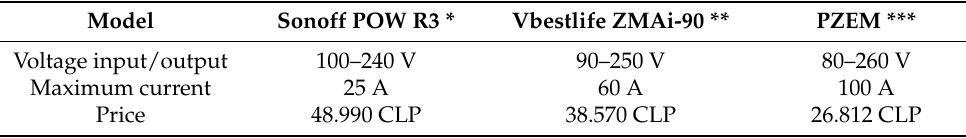
Table A2. Characteristics of energy metering devices.